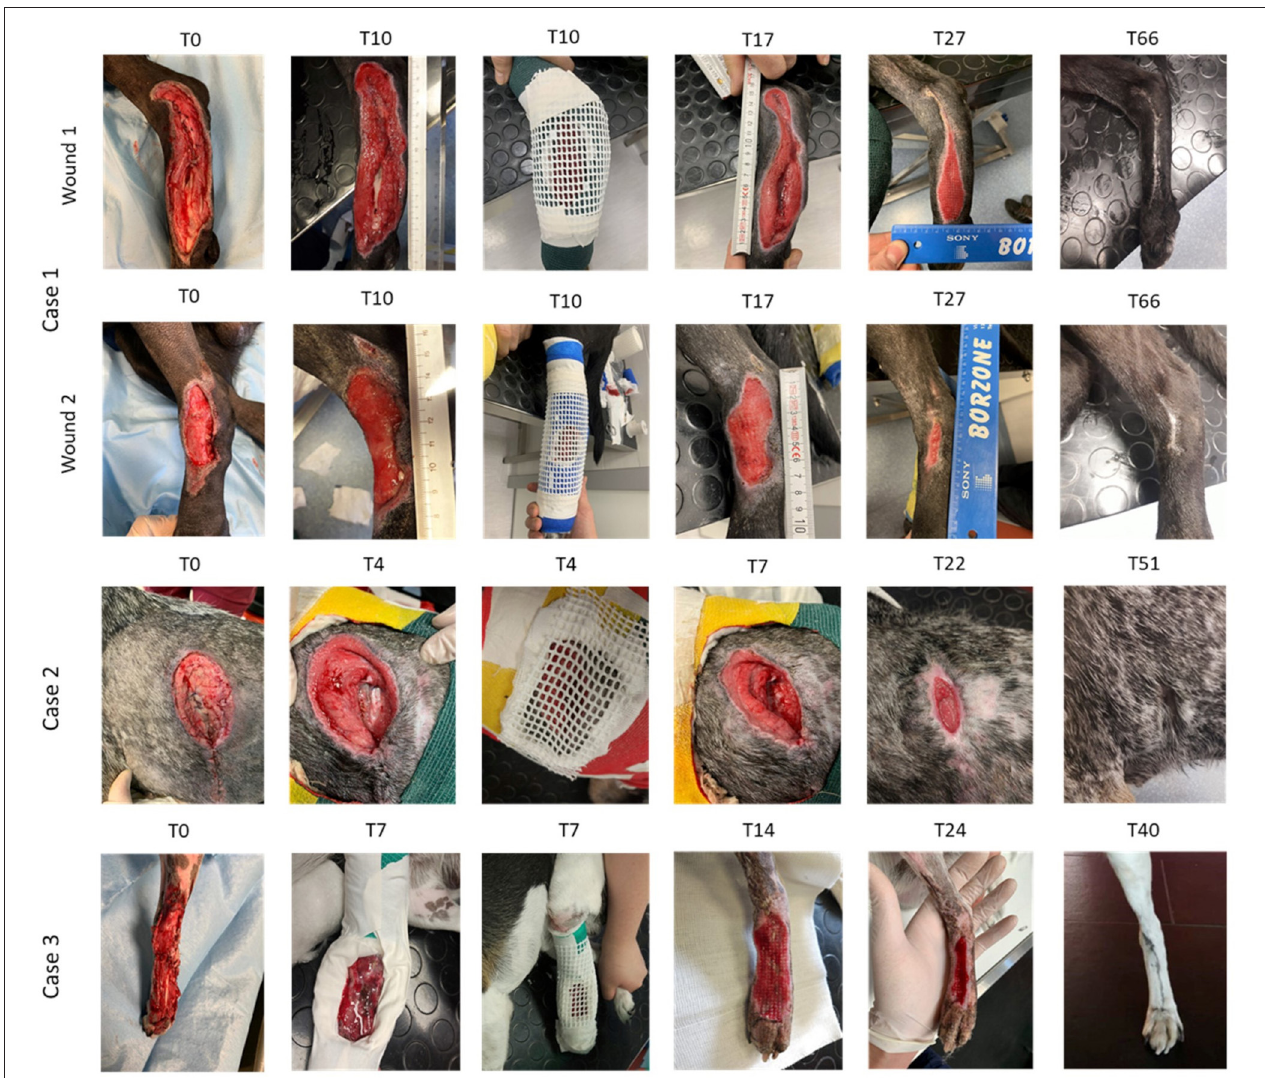
FIGURE 2 | Serial macroscopic images of the wounds of the three cases at different time points. Wound 1, right limb. Wound 2, left